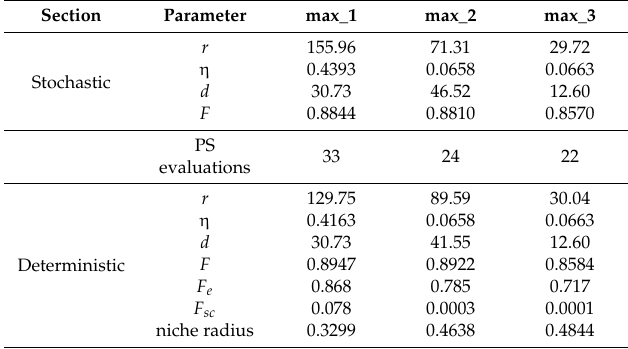
Table 2. Maxima found by means of